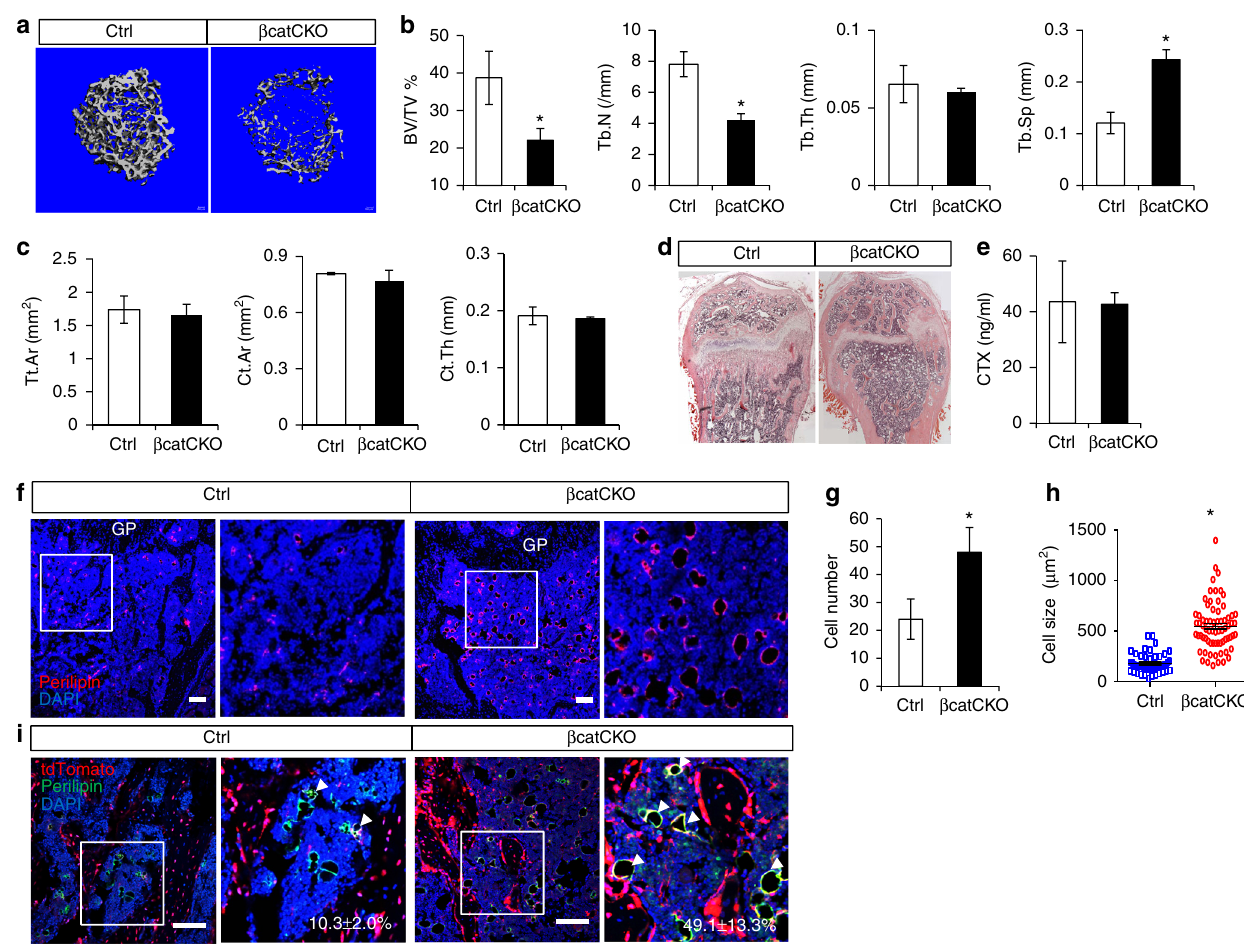
Fig. 6 β -Catenin deletion in MMPs leads to osteopenia and fate switch toward adipogenesis. Gli1-CreER T2 ; Ai9 (Ctrl), or Gli1-CreER T2 ;Ai9; β -catenin c/c ( β catCKO) littermate mice were treated with TM at 1 month of age and analyzed after 1 month. a µ CT images of cancellous bone in distal femur. b Trabecular bone parameters from µ CT analyses of distal femur. c Cortical bone parameters from µ CT analysis of femoral diaphysis. Tt.A, total area, Ct.Ar cortical area, Ct.Th cortical thickness. d H&E staining for distal femur. e Serum CTX-I levels. f Immuno fl uorescence staining of Perilipin (red) on sections of distal femur. Boxed areas shown in magni fi ed images to the right. Scale bar, 100 µ m. GP growth plate. g Number of Perilipin + adipocytes within cancellous bone region extending 400 µ m from the growth plate of distal femur in two sections per mouse and three mice per genotype. Data represent mean ± SD. h Area of Perilipin + adipocytes (meansured by imageJ) from the same area as g . Data was collected from two sections per mouse and three mice per genotype. A total of 80 adipocytes in each genotype (each represented by one data point) were quanti fi ed. i Confocal images showing tdTomato + cells (red) and immuno fl uorescence staining of Perilipin staining (green) on sections of distal femur. Boxed areas are shown in magni fi ed images to the right. Scale bar: 100 µ m. Arrowheads indicate Perilipin + tdTomato + adipocytes. Percentage (mean ± SD) of Perilipin + tdTomato + over Perilipin + adipocytes was calculated within cancellous bone region extending 400 µ m from the growth plate in two sections per mouse and three mice per genotype. * p < 0.05, n = 3, paired Student's t